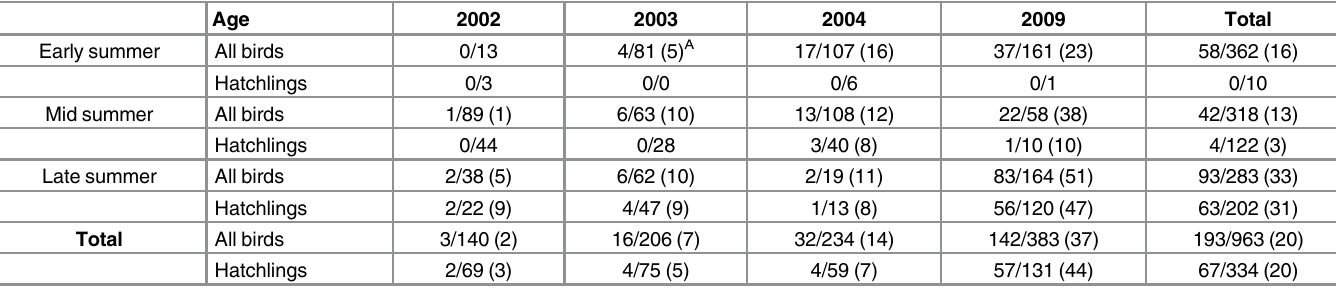
Table 2. Within-season variation of Sindbis virus antibody prevalence in birds in the River Dalälven floodplains,